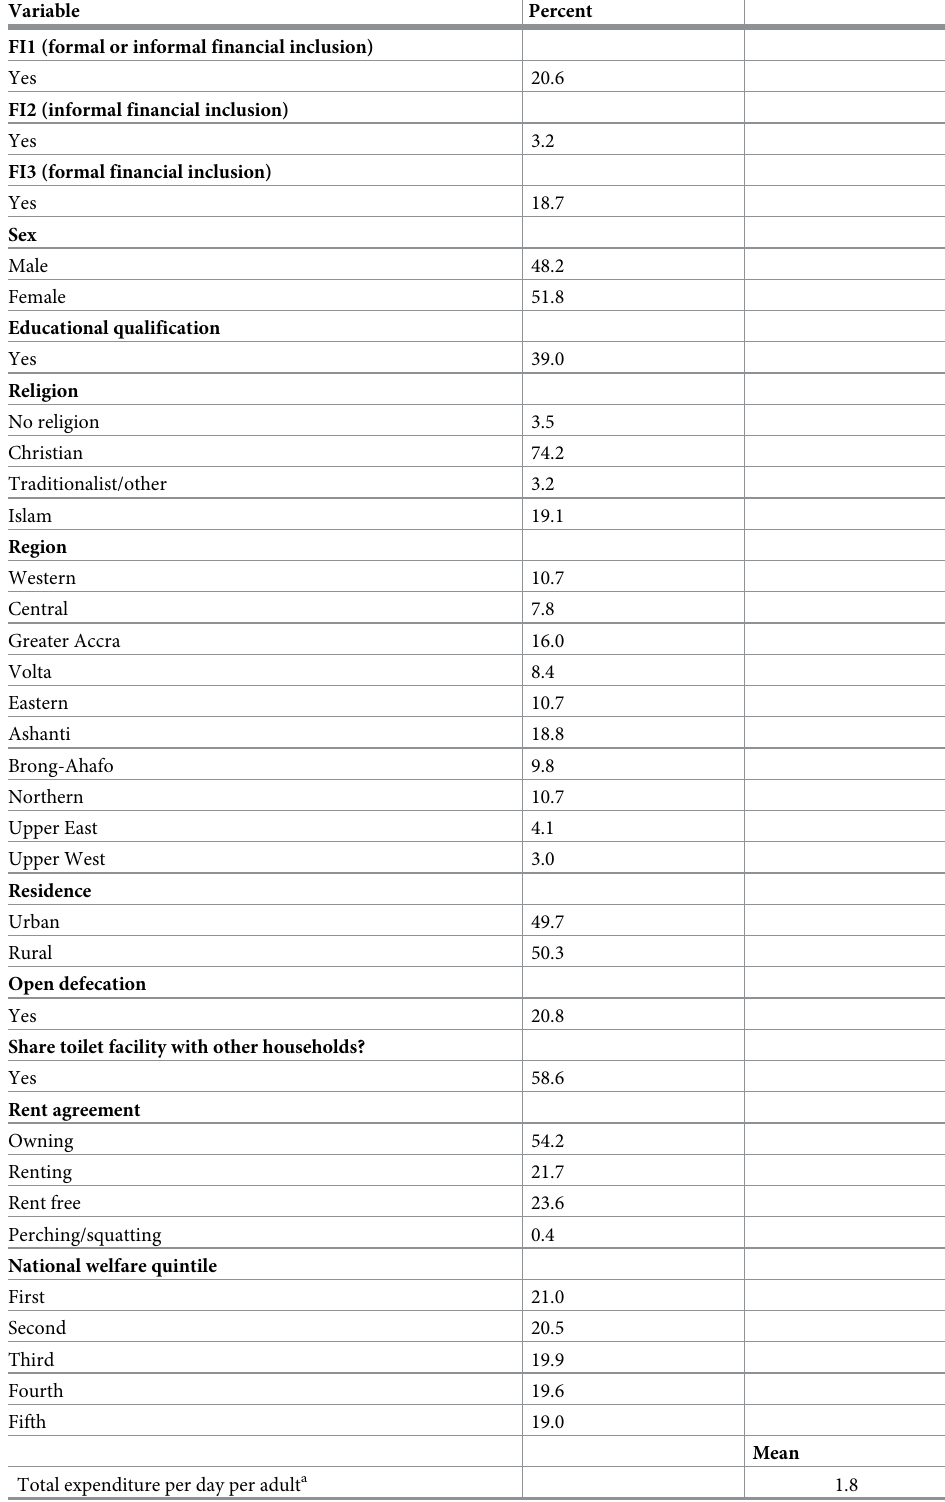
Table 1. Socio-demographic background of